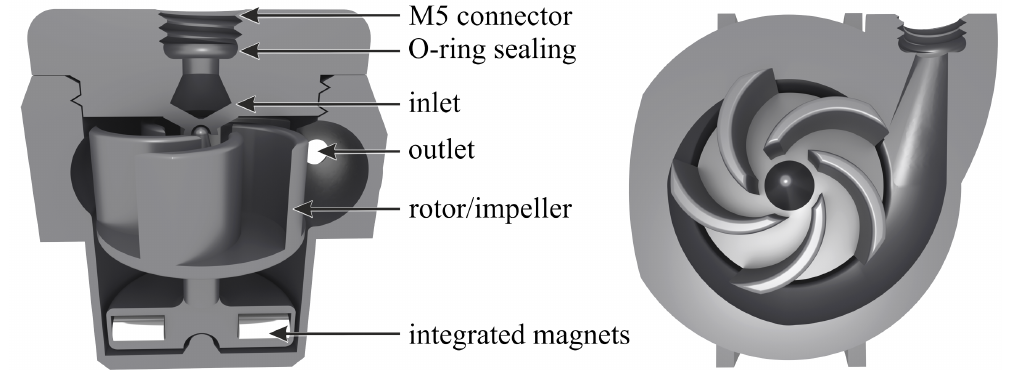
Figure 2. Perspective cut view from side ( left ) and top ( right ) of 3D-printed centrifugal pump design consisting of three separate parts: rotor with embedded permanent magnets (2 mm × 4 mm) and impeller blades, pump housing with outlet connector and inlet lid. The overall width, depth and height of the pump is 28 mm × 30 mm × 24 mm,